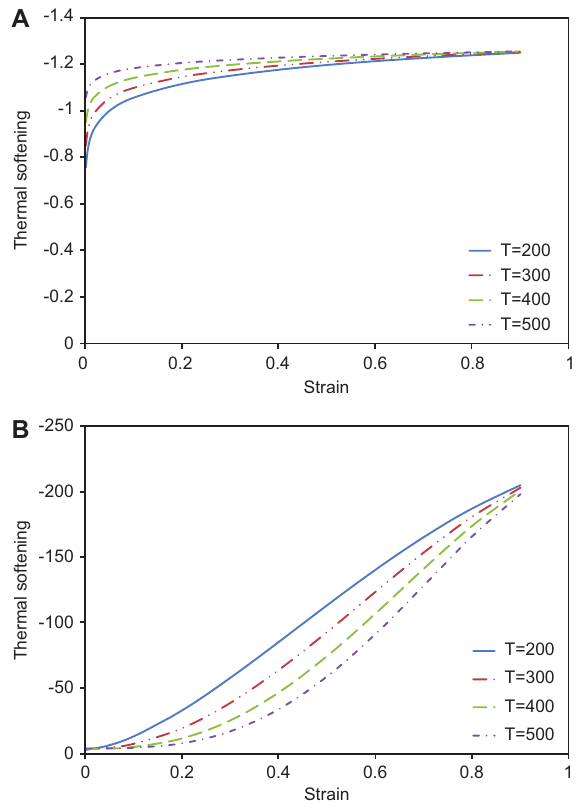
Figure 16 Change of thermal softening vs. strain of CR-1018 steel for different strain rates at temperatures of (A) 300 K and (B) 500 K.